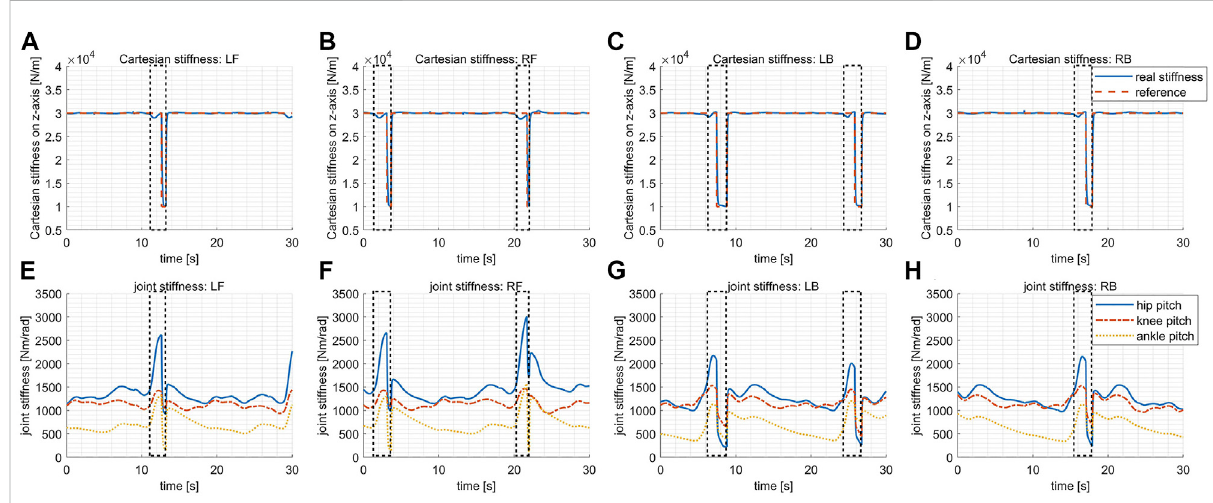
FIGURE 7 TheCartesianstiffness andthecorrespondingoptimaljointstiffness inthevariable stiffness locomotion.The dashedboxesindicatetheperiods when the corresponding leg is in swing. (A) The desired/actual Cartesian stiffness for the leg LF. (B) The desired/actual Cartesian stiffness for the leg RF. (C) The desired/actual Cartesian stiffness for the leg LB. (D) The desired/actual Cartesian stiffness for the leg RB. (E) The optimal joint stiffness for the leg LF. (F) The optimal joint stiffness for the leg RF. (G) The optimal joint stiffness for the leg LB. (H) The optimal joint stiffness for the leg